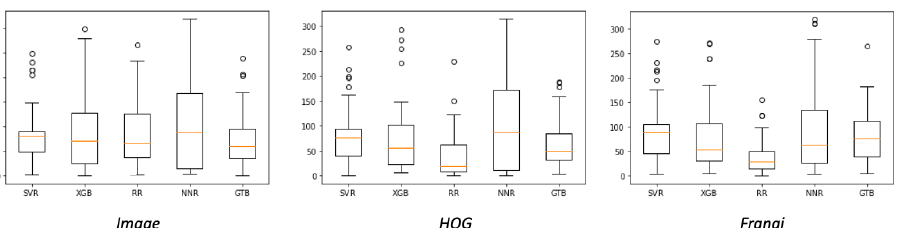
Figure 5. Various boxplots showing the results of applying regressors on: ( Left ) just the image as input, and on extracted features using ( Middle ) HOG and ( Right ) Frangi filtering.